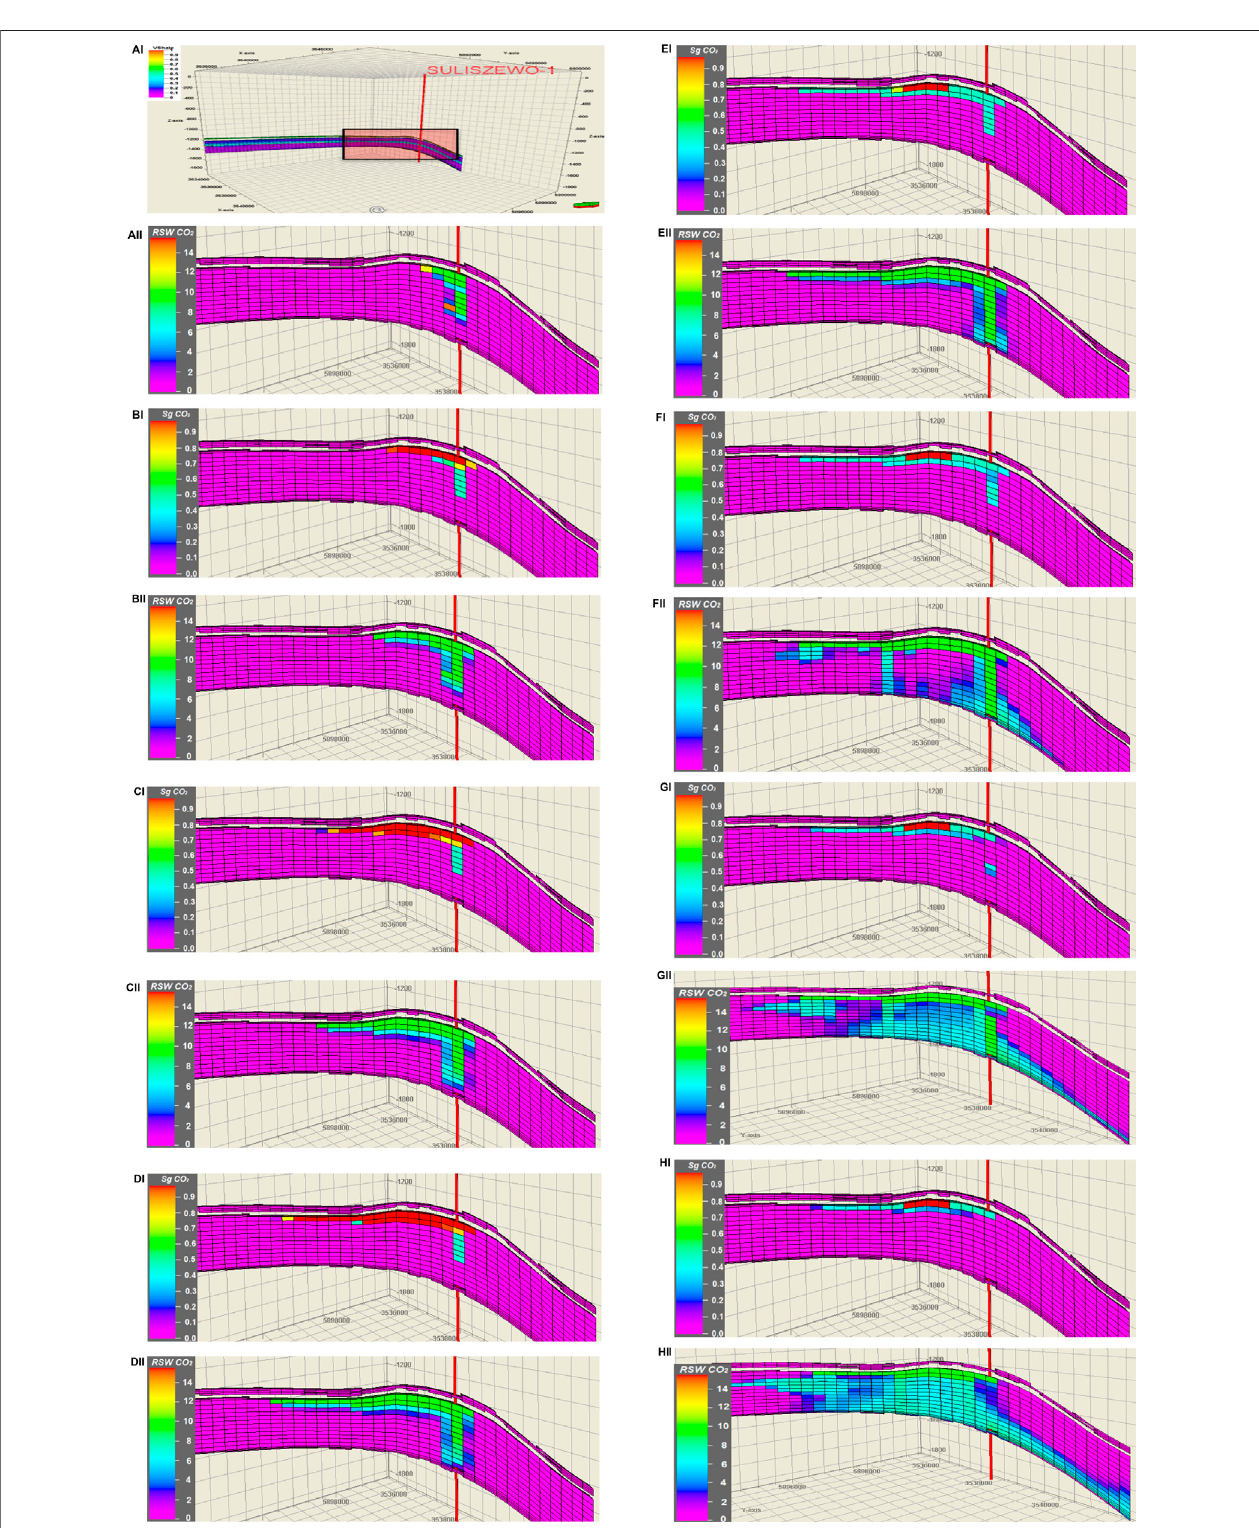
FIGURE 5 | Determined section enlarged in the (I) distribution of free CO 2 saturation in the structure and (II) structure saturation distribution of CO 2 dissolved in brine (RSW CO2 -molar fraction) after (A) 5, (B) 15, (C) 20, (D) 25, (E) 50, (f) 200, (G) 500 and (H) 1,000 years from the start of injection.